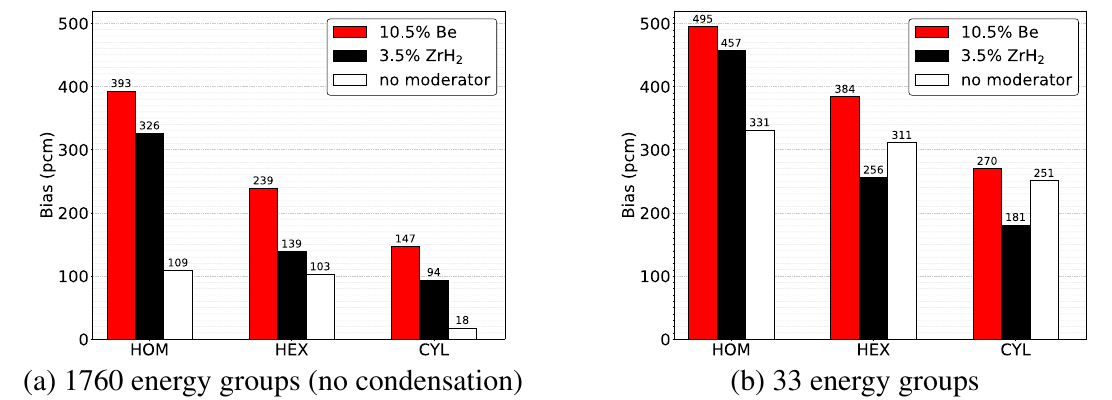
Figure 4: Global core reactivity bias of A3-T4 scheme compared to T4